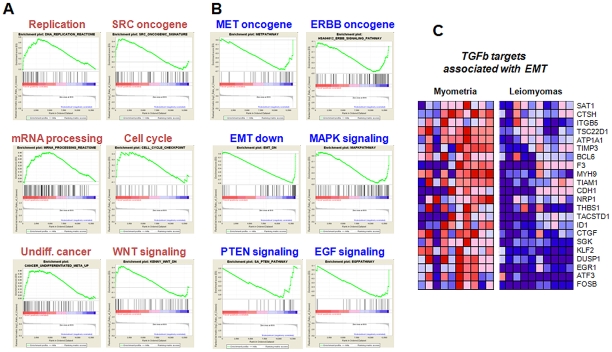
Gene Set Enrichment Analysis (GSEA) of mRNA profiling results from primary ULMs and matched myometria.The histograms show the distribution of select top GSEA molecular signatures from predefined C2 and C5 categories (accessible from the MolSig database at http://www.broadinstitute.org/gsea/msigdb/index.jsp). The leading edge (most significant genes) are shown as vertical bars accumulated either left and below the peak of green enrichment score plot (A) or right of the valley of the green plot (B), indicating the respective up- or down-regulated genes of each shown GSEA characterized by the highest enrichment score. C The leading edge (genes with the highest enrichment score) of the EMT-down category (shown in B) is shown as individual gene expression-based heat map and indicates downregulation of the TGF-β signal and of its canonical targets in ULMs.